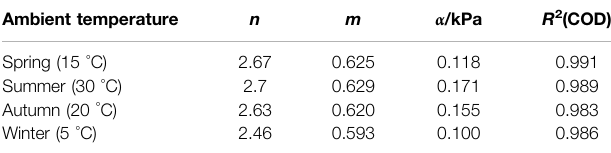
TABLE 4 | Fitting parameters of the Van Genuchten model for the SWCC of tailings at different ambient temperature. Ambient temperature